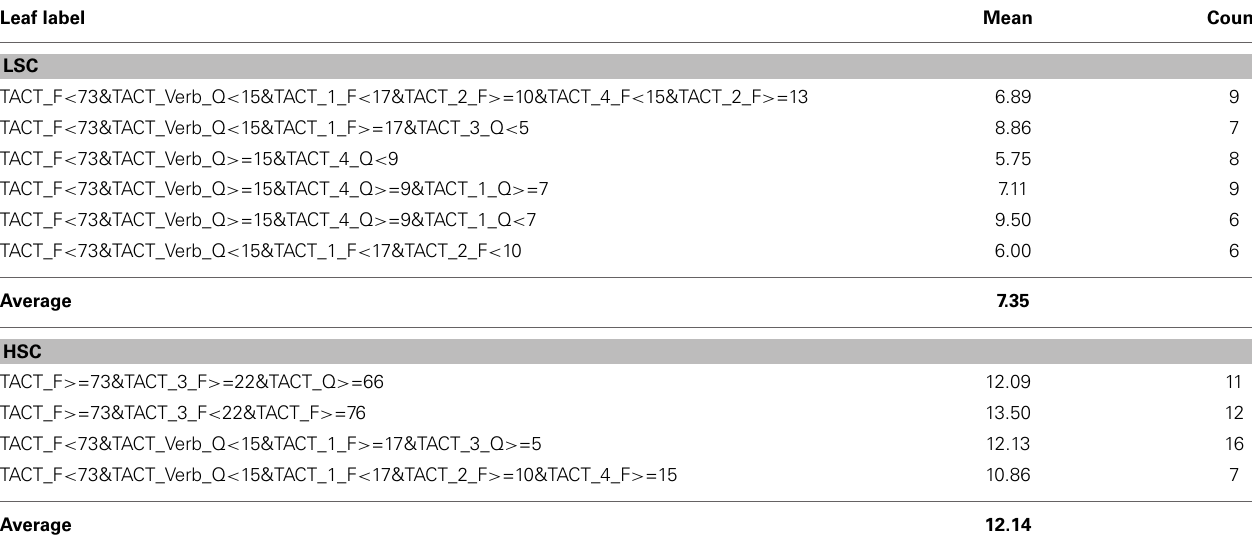
Table 1 | Classification rules created by the decision tree to classify RAT scores based on TACT measures to LSC (upper panel) and HSC (lower panel)